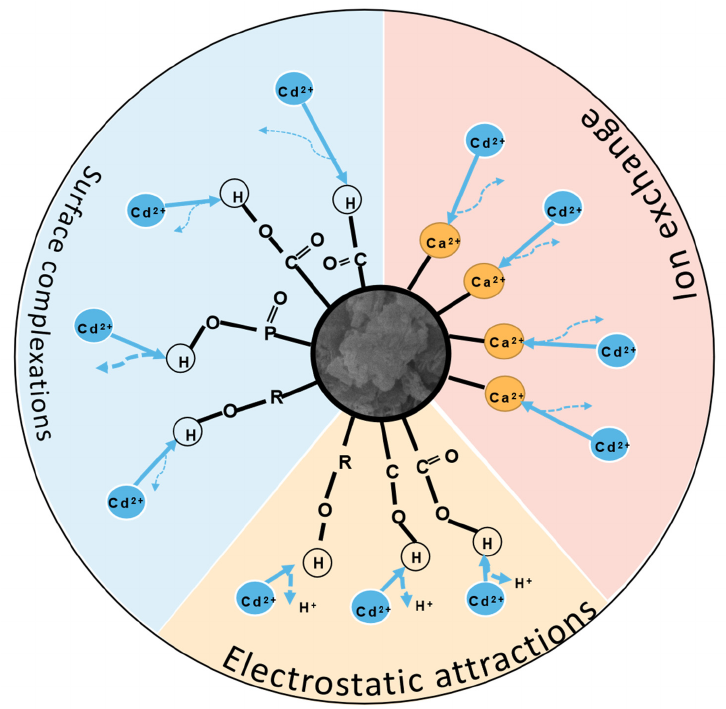
Figure 8. Adsorption mechanisms of Cd 2+ uptake by BC and BCH samples.